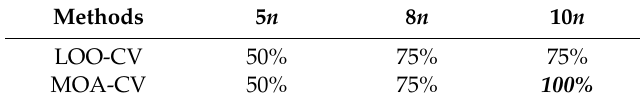
Table 9. Accurate rate of removing worst models by mean of LOO-CVerror and MOA-CVerror.